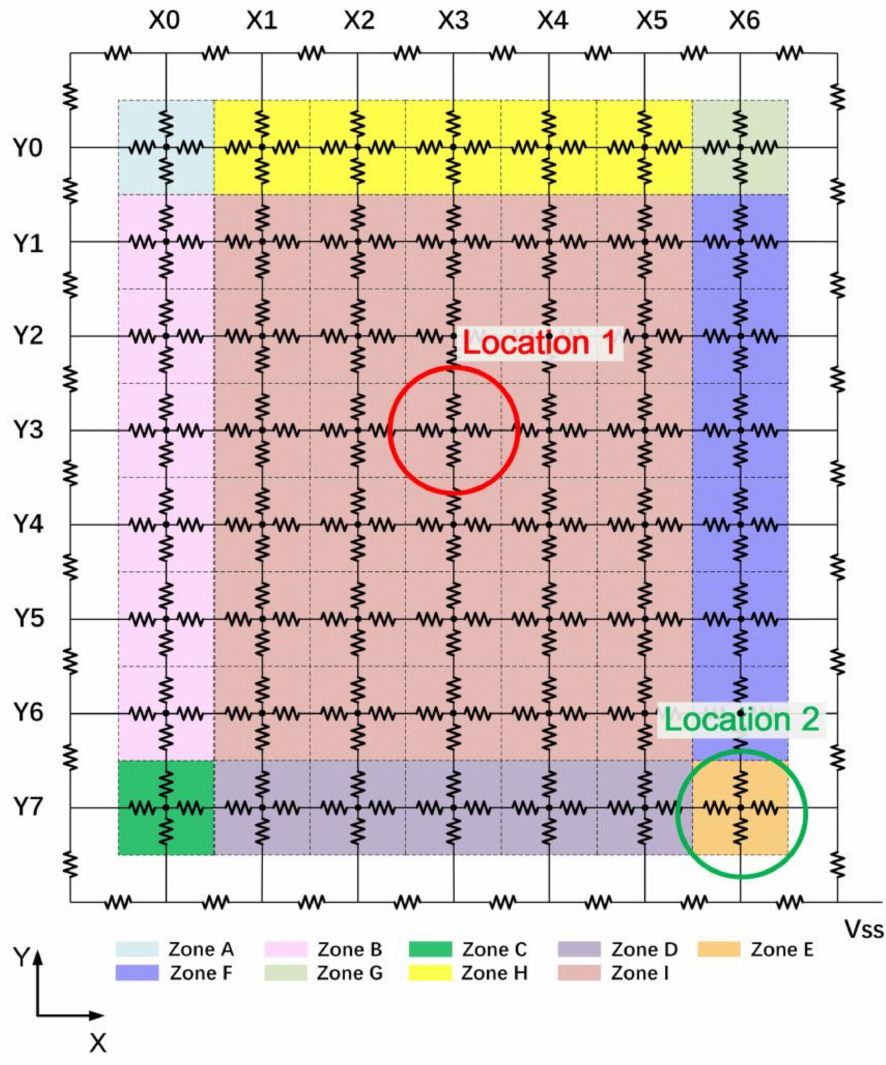
Figure 8. Multi-finger NMOS substrate resistance network in ESD